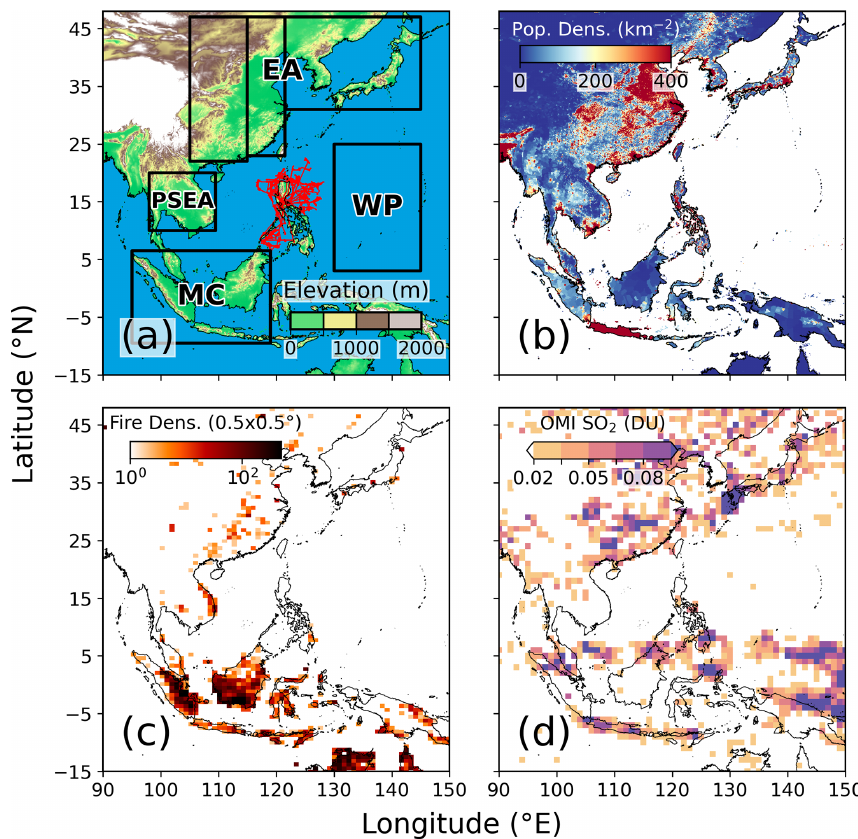
Figure 1. Maps of (a) ground elevation from the Global Multi-resolution Terrain Elevation Data 2010 (GMTED2010), with flight tracks in red and approximate source regions in labeled boxes (peninsular Southeast Asia (PSEA), the Maritime Continent (MC), East Asia (EA), and the West Pacific (WP)), (b) 2020 population density from the Center for International Earth Science Information Network (CIESIN) Gridded Population of the World (GPW) v4, (c) MODIS active fire hotspot density (only fires tagged with >80% confidence) averaged at 0.5 ◦ × 0.5 ◦ resolution from 1 August to 15 October 2019, and (d) OMI-retrieved planetary boundary layer (PBL) SO 2 averaged over the same